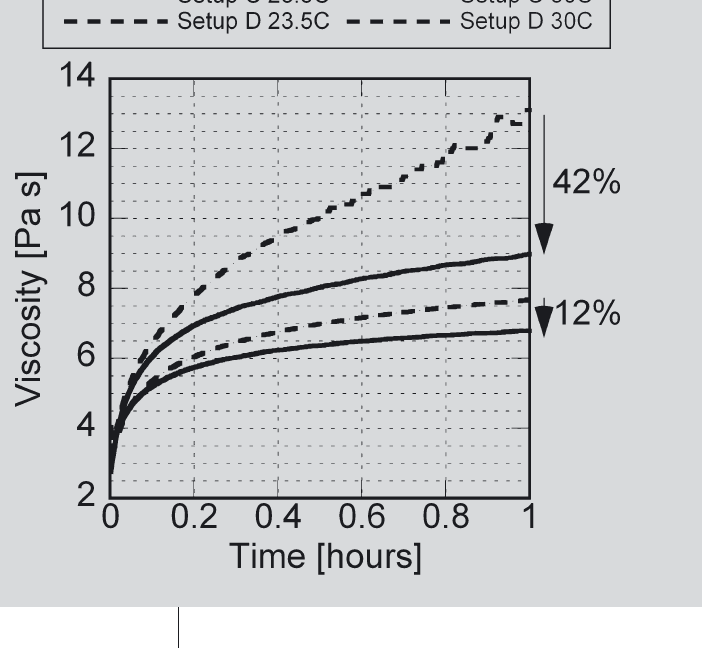
Figure 5: Transient viscosity of colloidal aqueous suspen- sions of precipitated calcium carbonate at 1 s -1 and differ- ent temperatures (Setup C and